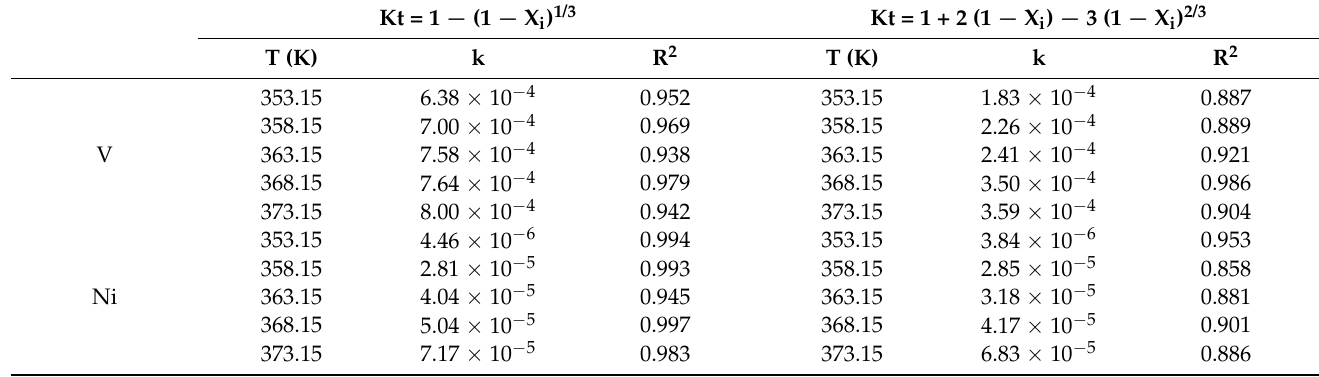
Table 5. Kinetic parameters at different leaching temperatures using different kinetic